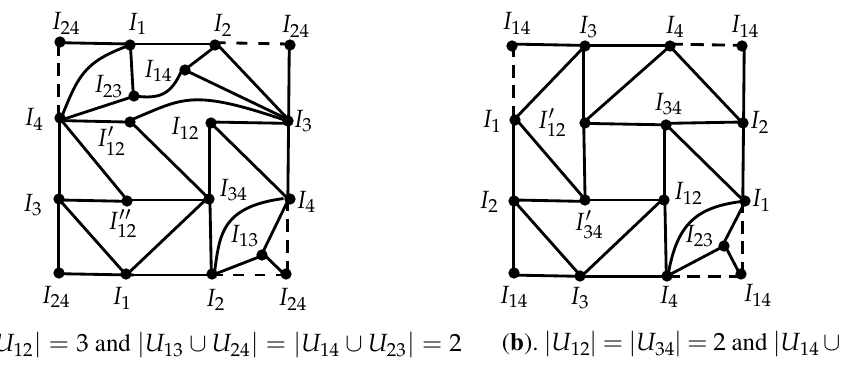
∪ 4 U n | = 4 with | U 12 ∪ U 34 | = 4. n = 1